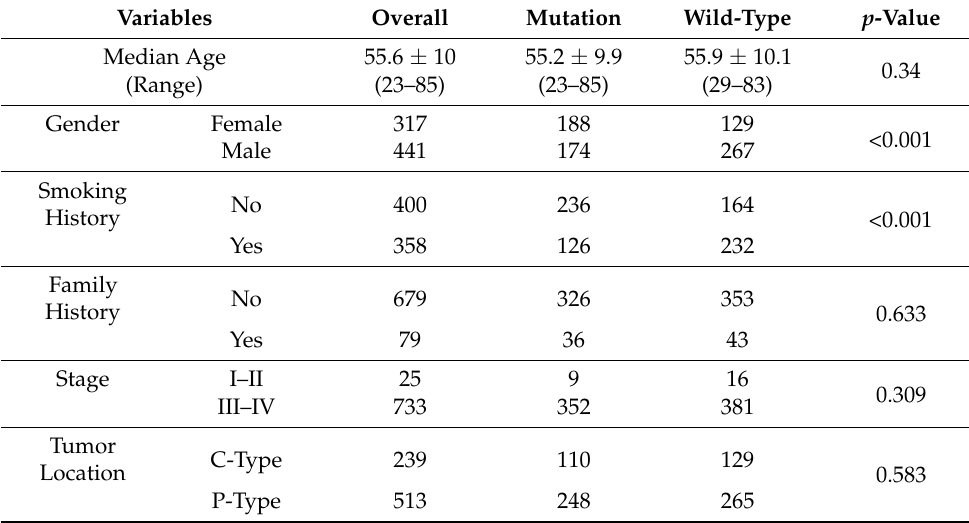
Table 2. Patients’ baseline characteristics.